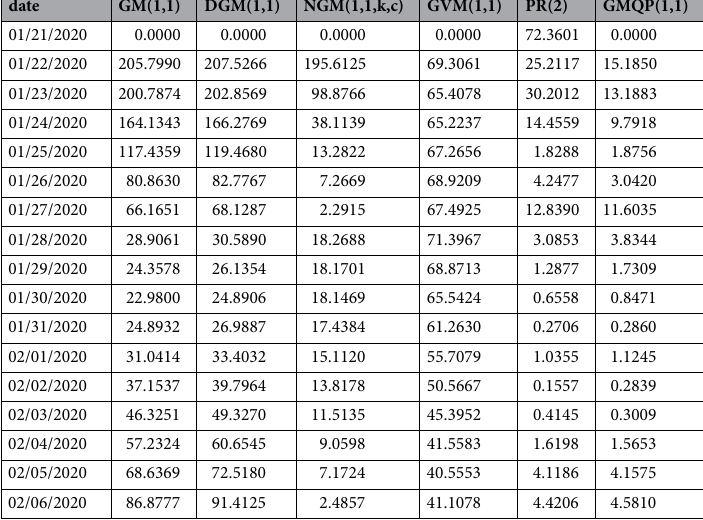
Table 10. The APEs of different model in the confirmed cases of COVID-19 of China, (%).